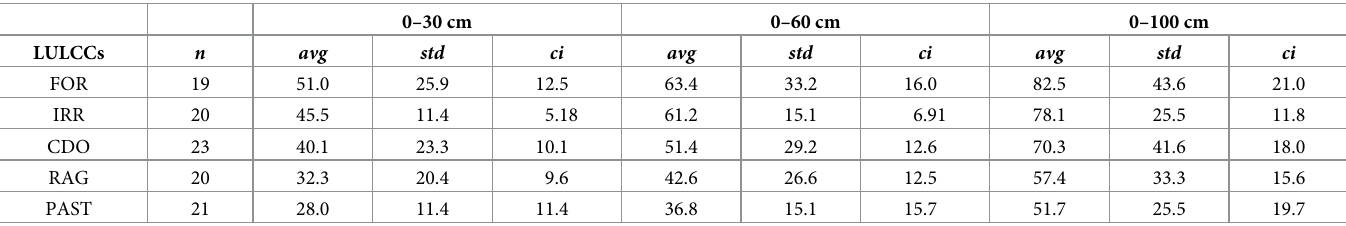
Table 3. Average soil carbon stocks in Mg-C ha − 1 for depths of 0–30 cm, 0–60 cm, and 0–100 cm for different land use and land cover classes in Western